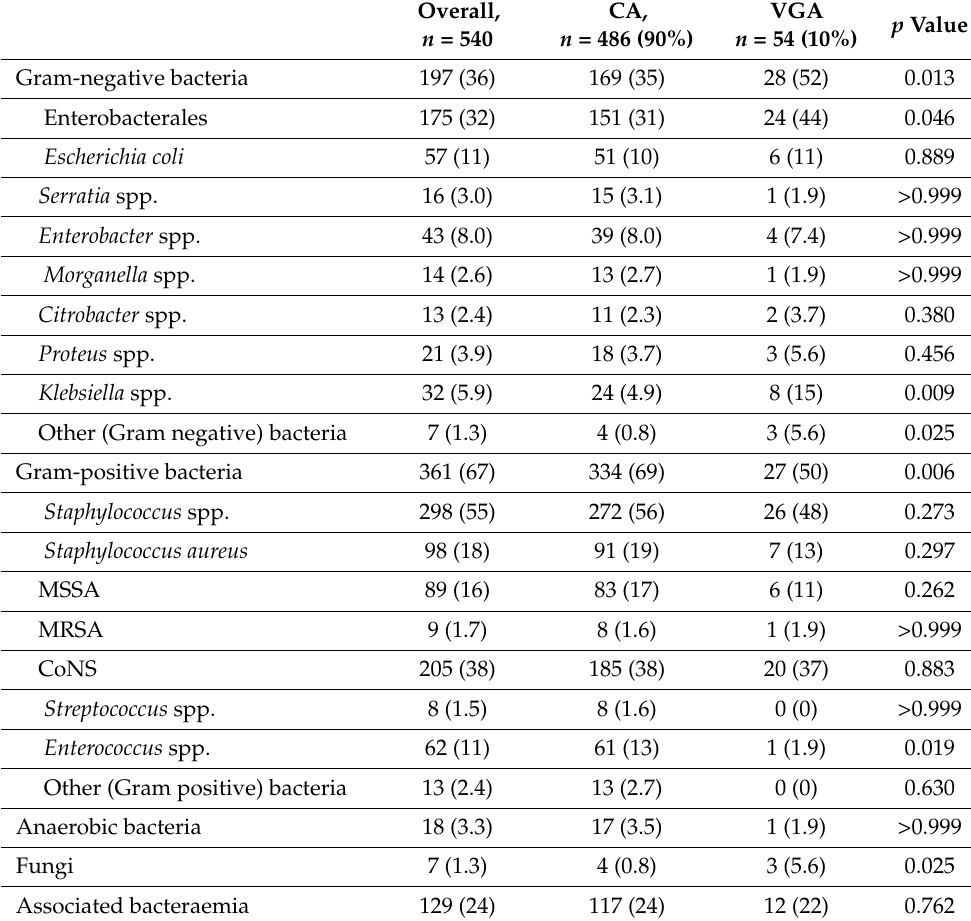
Table 3. Bacterial characteristics of SSI according to antibiotic